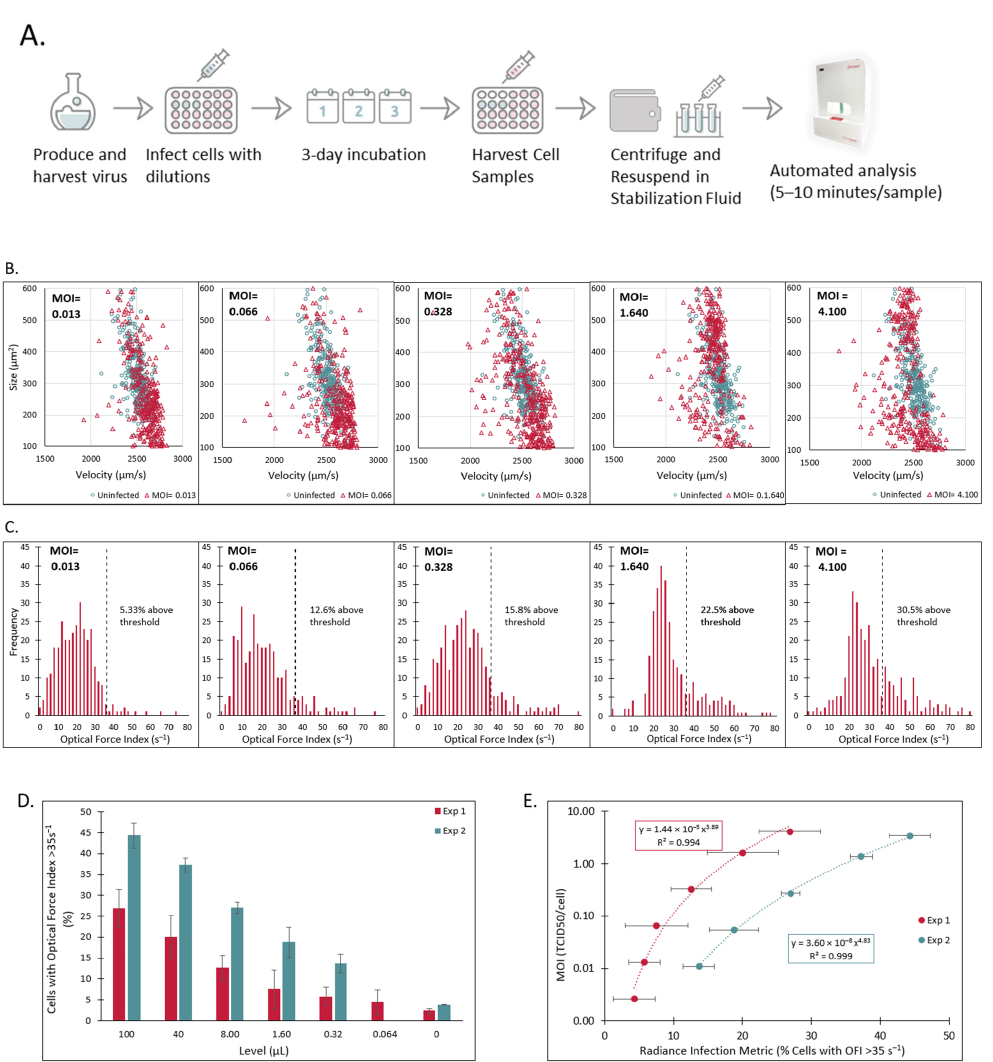
Figure 5. LumaCyte Radiance analysis of Vero cells grown on 24-well plates and infected with MV at varying MOIs resulted in an infection metric that correlates well with MOI. ( A ). Workflow for MV infectivity assay. Cells are grown on 24-well plates and infected with MV at varying MOIs. At 3 days post-infection (3 DPI), cells are harvested from the plates, centrifuged, and resuspended in stabilization buffer before analyzing on LumaCyte’s Radiance instrument. ( B ). Representative scatter plots compare cell area-based size vs. velocity profiles for uninfected cells (blue) and MV infected cells (red) at 3 days post-infection (3 DPI). Each graph represents cells infected with a different MOI. Each dot represents a single cell analyzed by Radiance. ( C ). Representative histograms show the differences in optical force index profiles for MV infected cells at 3 days post-infection (3 DPI) for varying MOI. Bar heights represent the number of cells with an optical force index falling within the given bin range (bin width = 2). The dotted line represents the optical force index threshold set as the Radiance infection metric (OFI > 35 s − 1 ) for this study. The percentage of the cell population with an OFI > 35 s − 1 is shown on each plot. ( D ). Comparison of Radiance infection metric (percentage of cells with OFI > 35 s − 1 ) at 3 days post-infection (3 DPI) for cells infected with MV at varying levels across two unique cell infectivity experiments ( n = 3). ( E ). Correlation between Radiance infection metric (percentage of cells with OFI > 35 s − 1 ) and MOI for cells infected with MV and harvested at 3 days post-infection (3 DPI). Each line represents a separate experiment with unique cell source and stock virus titer. R 2 = 0.994 ( n = 3) for Experiment 1, and R 2 = 0.999 ( n = 3) for Experiment 2. Table 3. Calculated Potency Values for MV Cell Infectivity Assay Samples. Table detailing the Ra- diance infection metric, Calculated MOI, and Calculated Titer based on the correlation between the LFC data and Input MOI for each cell infectivity experiment. Finally, the average log 10 difference between the stock titer and calculated titer for each sample MOI as well as the average for all points in a given experiment are given in the final column.